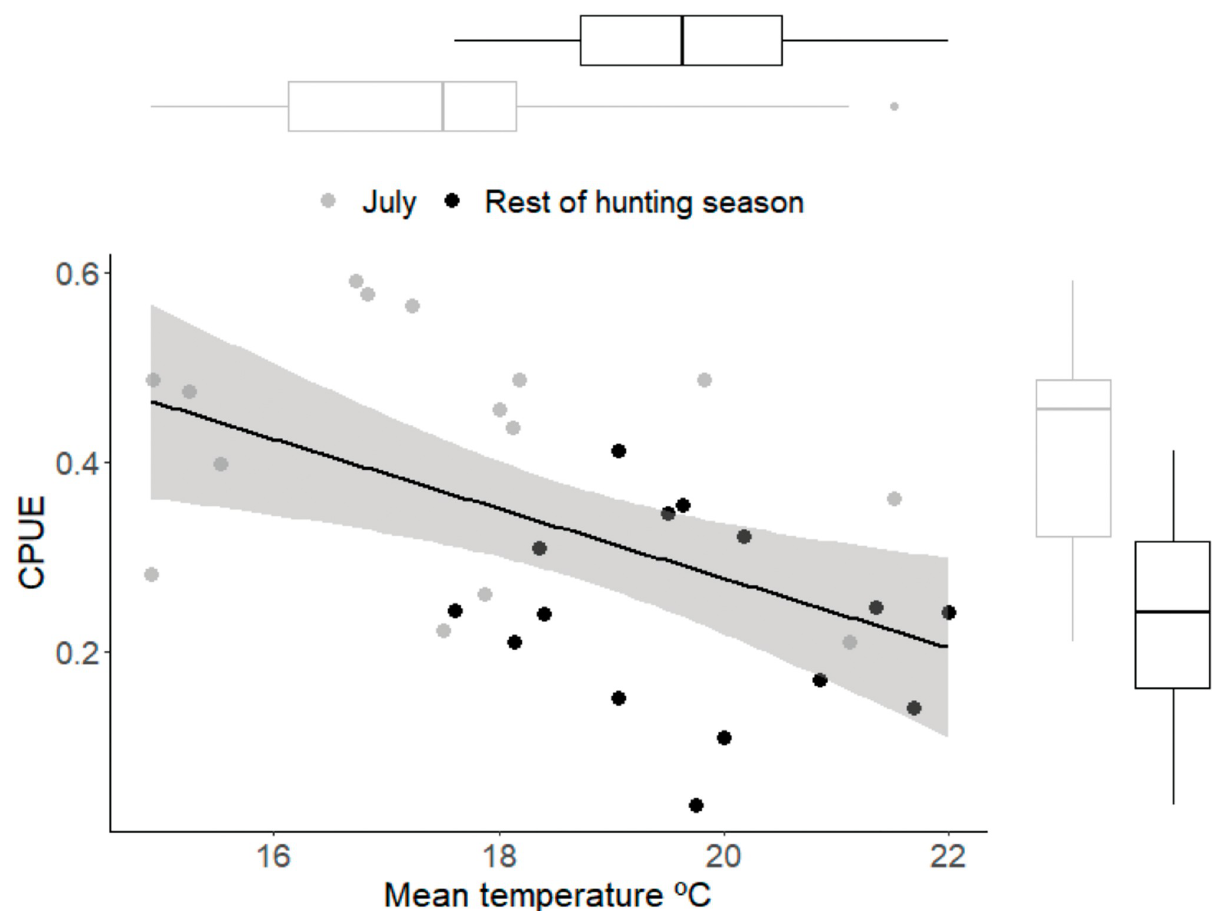
Fig 6. Capture rate (CPUE) in relation to mean temperature ( º C) for the most productive month (July) and for the rest of the hunting season. The Gaussian regression for captured taxa (CPUE = 1.01–0.03 � mean T º C) is shown.